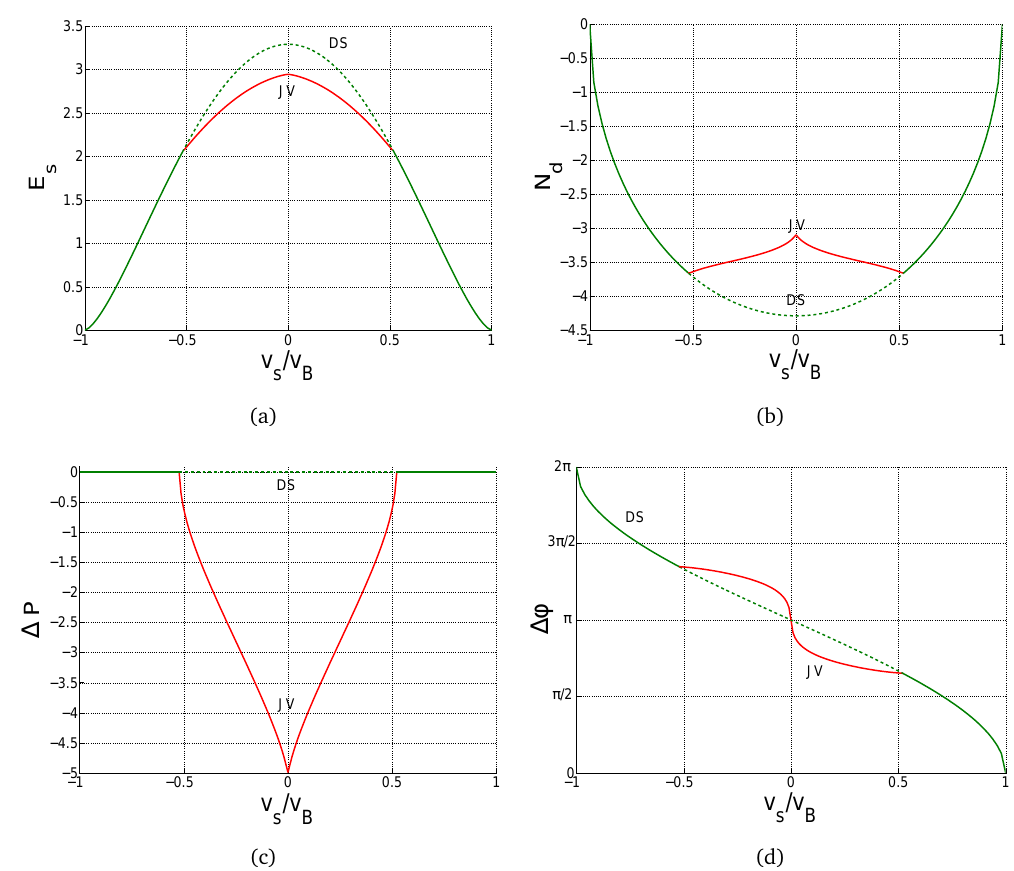
Figure 6: No cross-interaction, intermediate coupling regime ( γ = 1, ν = 0.15). Energy (a), missing particle number (b), angular momentum (c) and phase difference (d) as a function of velocity. Properties of Josephson vortices (labeled ‘JV’) are plotted in red and those of dark solitons (labeled ‘DS’) in green. Solid lines indicate stable solutions, while dashed lines depict unstable